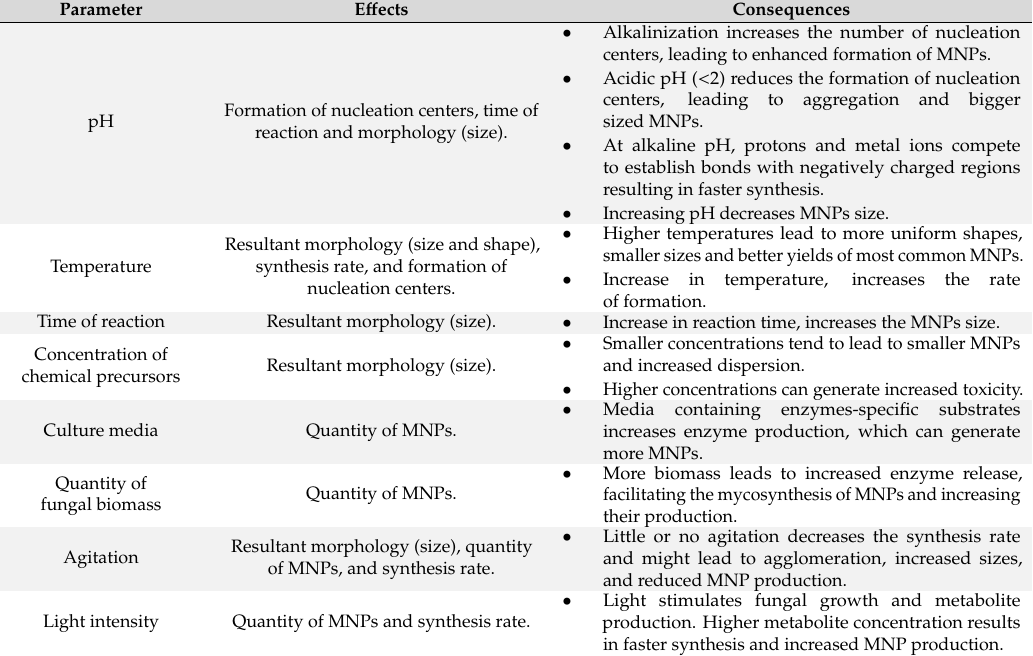
Table 3. Parameters a ff ecting mycogenic synthesis of MNPs [17,52,80].